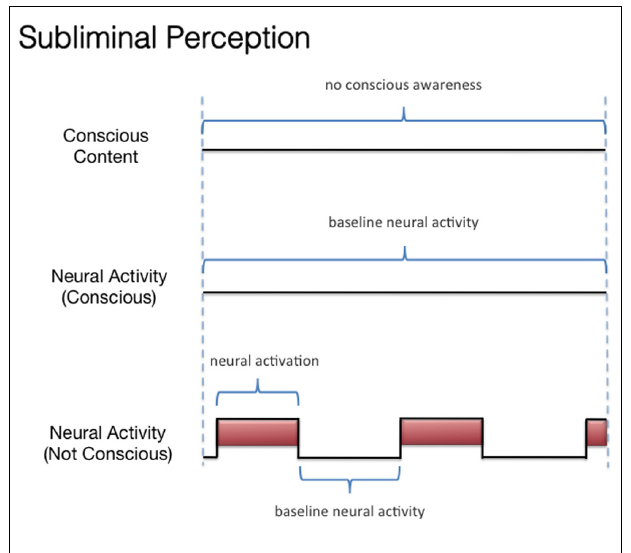
FIGURE 1 | Schematic representation of the relationship between the subjective events associated with subliminal perception of olfactory stimuli and hypothetical neural activity.